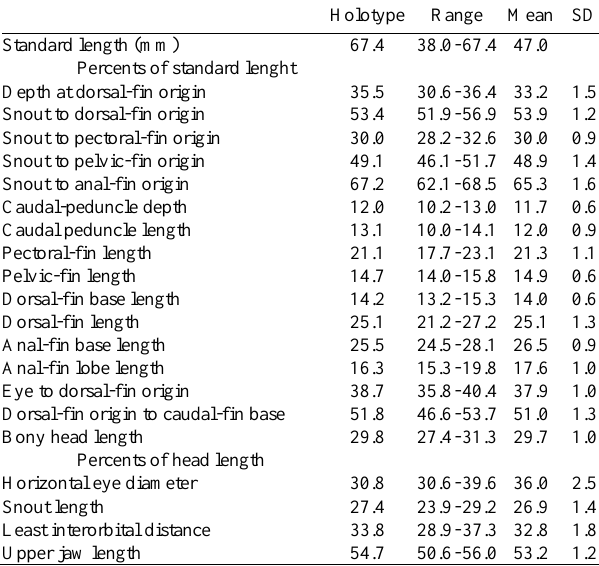
Table 1. Morphometric data of Moenkhausia chlorophthalma . N = 31, SD = standard deviation.